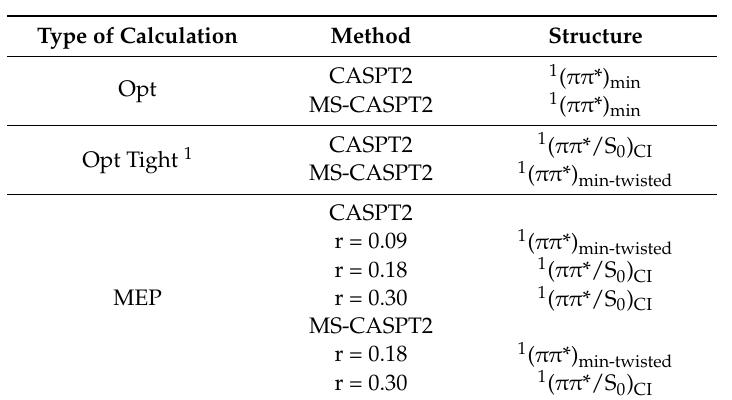
Table 2. CASPT2(10,8)/6-31G* geometry-optimization and MEP geometries obtained for thymine. r denotes the hypersphere radius employed in the calculation (in a.u.) [78].